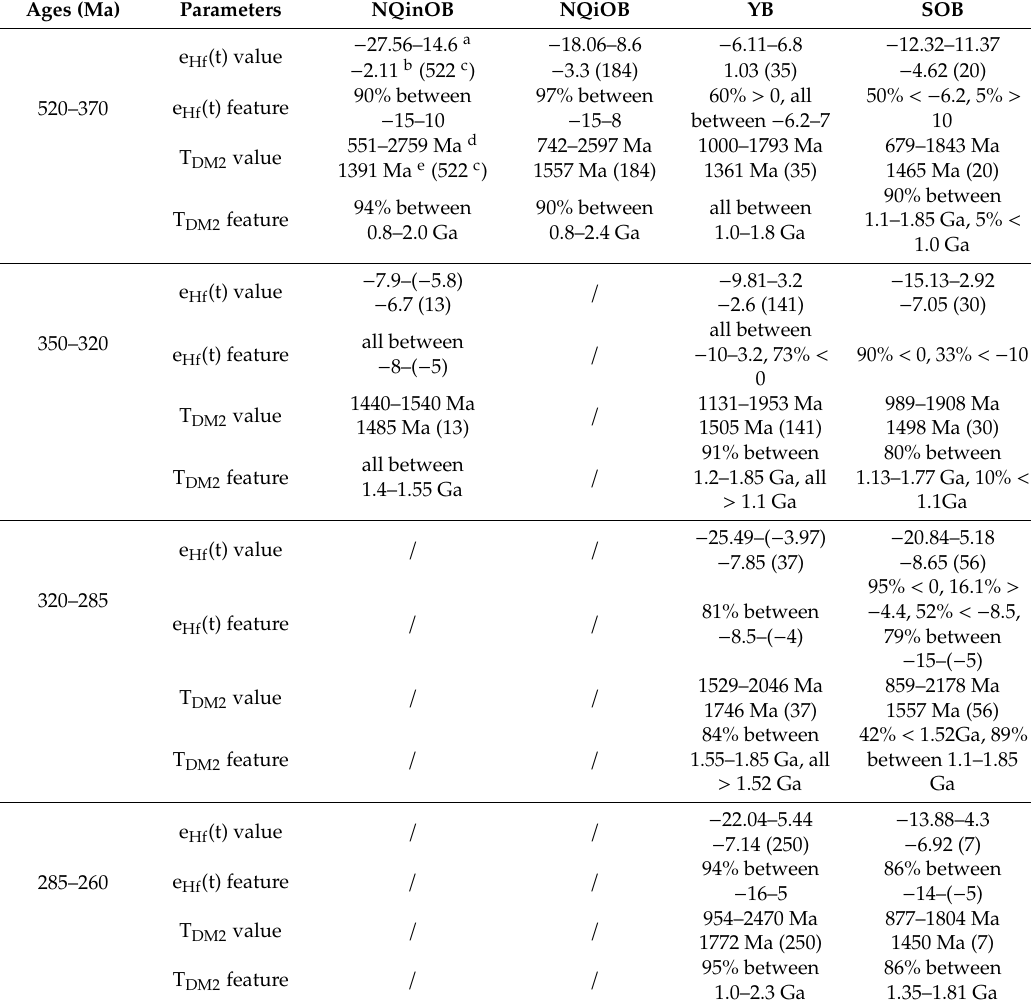
Table 2. Summarized the characters of Hf isotopic